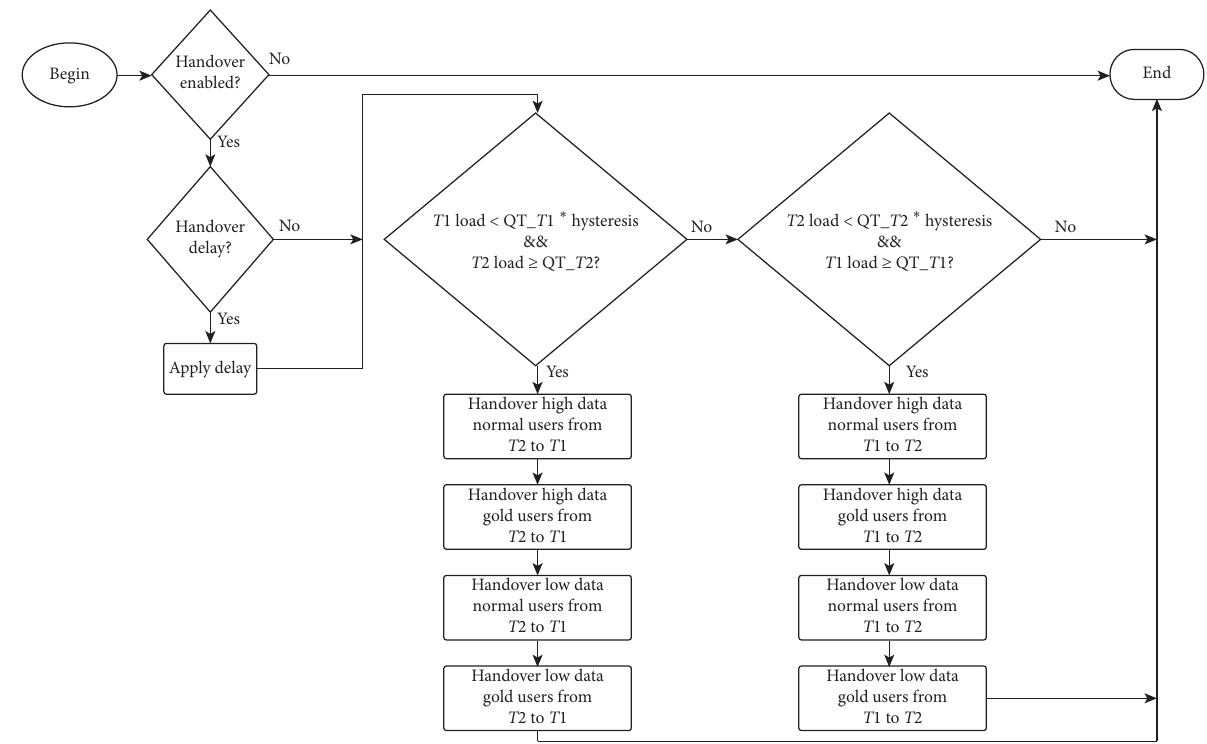
Figure 5: Flow handover flowchart.